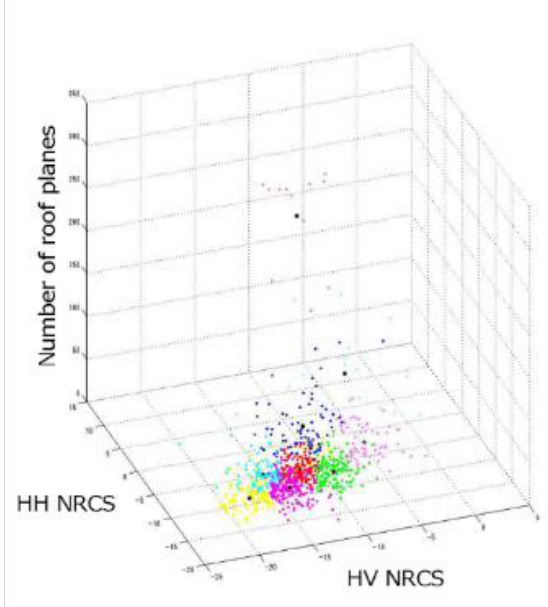
Figure 16. Building classification result using NRCS values and the number of roof segments (1)